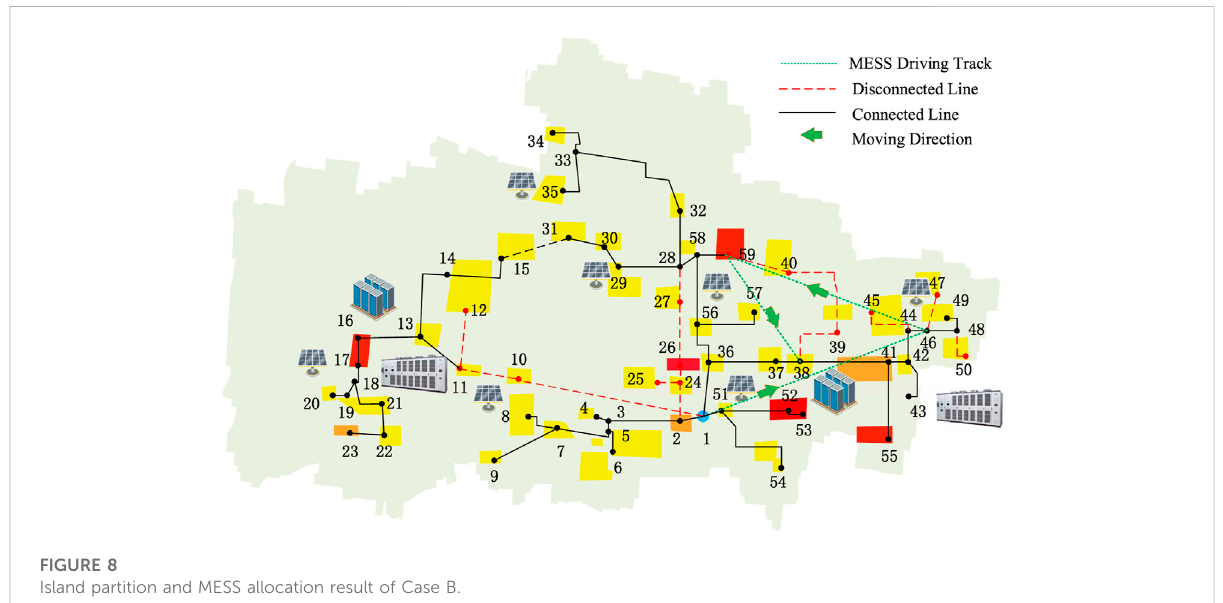
FIGURE 8 Island partition and MESS allocation result of Case B.